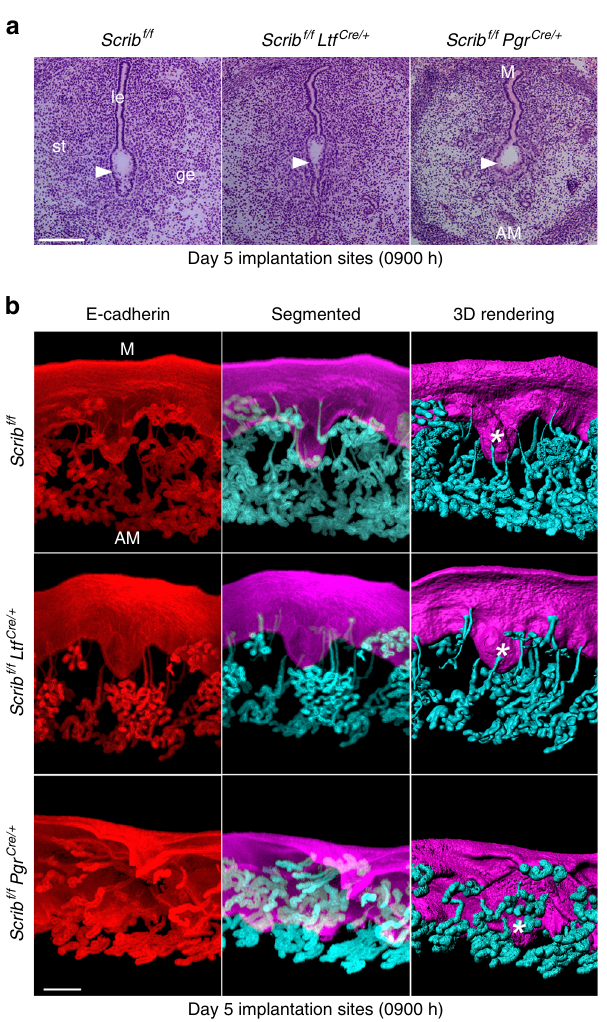
Fig. 2 Implantation is aberrant in Scrib f/f Pgr cre/ + mice. a Histology of day 5 of implantation sites in each genotype. Scale bar, 200 μ m. Arrowheads indicate the location of embryos. b 3D imaging of day 5 implantation sites in Scrib f/f , Scrib f/f Ltf cre/ + , and Scrib f/f Pgr cre/ + females. Images of E-cadherin immunostaining, segmented, and 3D rendered images of day 5 implantation sites in each genotype show the aberrant crypt-gland structure in Scrib f/ f Pgr cre/ + females. Images were generated by a Nikon A1R Multiphoton Microscope with LWD 16× objective with 3 µ m Z-stack. Scale bar, 200 μ m. Asterisks indicate the location of blastocysts. Each image is a representative of at least three independent experiments. M mesometrial pole, AM antimesometrial pole, le luminal epithelium, ge glandular epithelium, st stroma. (Fig. 3b). Fgf2 is also expressed in stromal cells around the blastocyst in a similar fashion as Bmp2 and Wnt4 on day 5 16 . In contrast to the expression of Bmp2 and Wnt4 , the expression of Fgf2 is distinct in stromal cells surrounding the blastocyst in Scrib f/f Pgr cre/ + mice at the area destined to become the PDZ in fl oxed uteri (Fig. 3b). Since Fgf2 is known to regulate cell proliferation 20 , we examined stromal cell proliferation on day 5 by Ki67 and pHH3 immunostaining. We found no alteration of epithelial cell proliferation, but stromal cells surrounding the implanting blastocyst show intense cell proliferation in Scrib f/f Pgr cre/ + mice (Supplementary Fig. 4). By comparison, stromal cells surrounding the embryo in fl oxed and Scrib f/f Ltf cre/ + mice show reduced cell proliferation, suggesting that initiation of differentiation of these cells promotes the formation of PDZ.